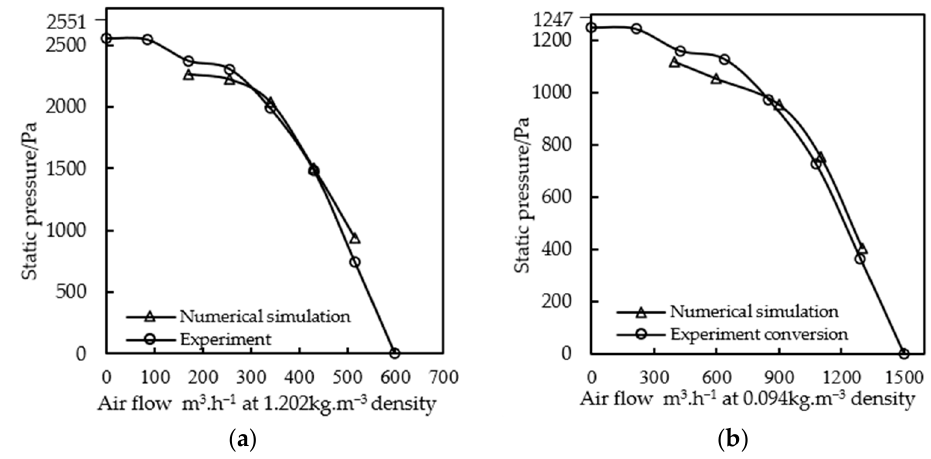
Figure 11. ( a ) The ground performance curve of the MIX-130 fan; ( b ) Stratospheric performance curve of the MIX-130 fan.